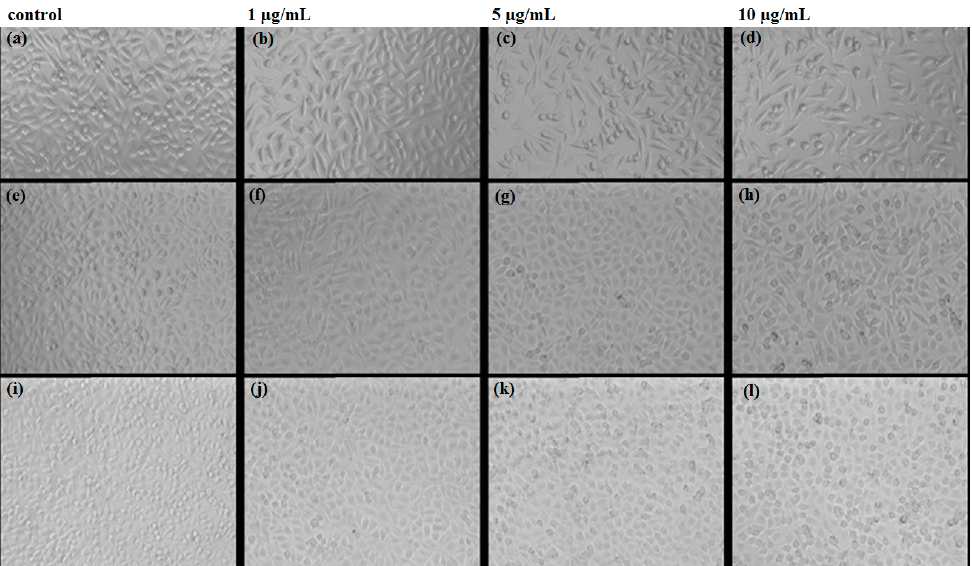
Figure 8. Images of optic microscopy at 24 ( a – d ); 48 ( e – h ) and 72 h ( i – l ) of the L929 cells grown in the presence of the obtained AgNPs.